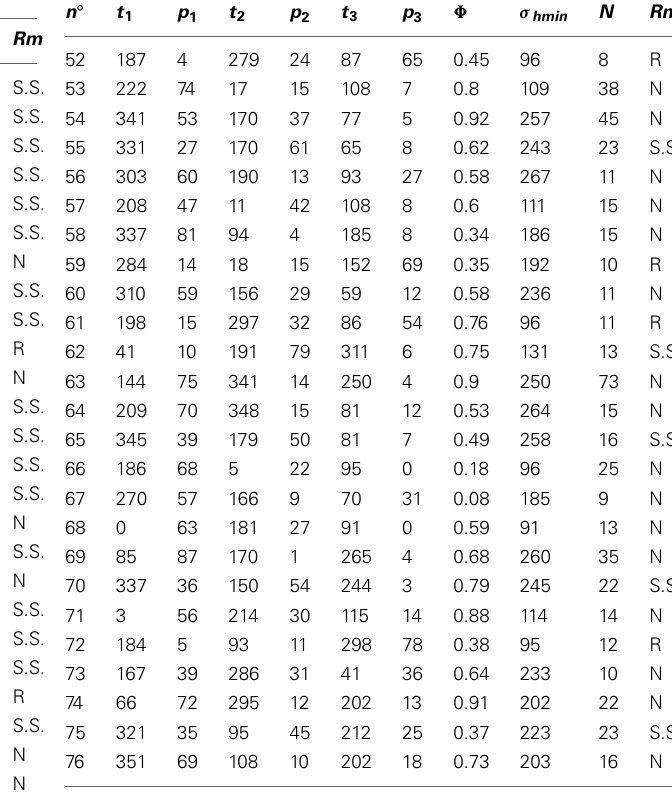
Table 1 | Stress tensor solutions computed for a damping parameter e = 0 . 6, model displayed in Figure